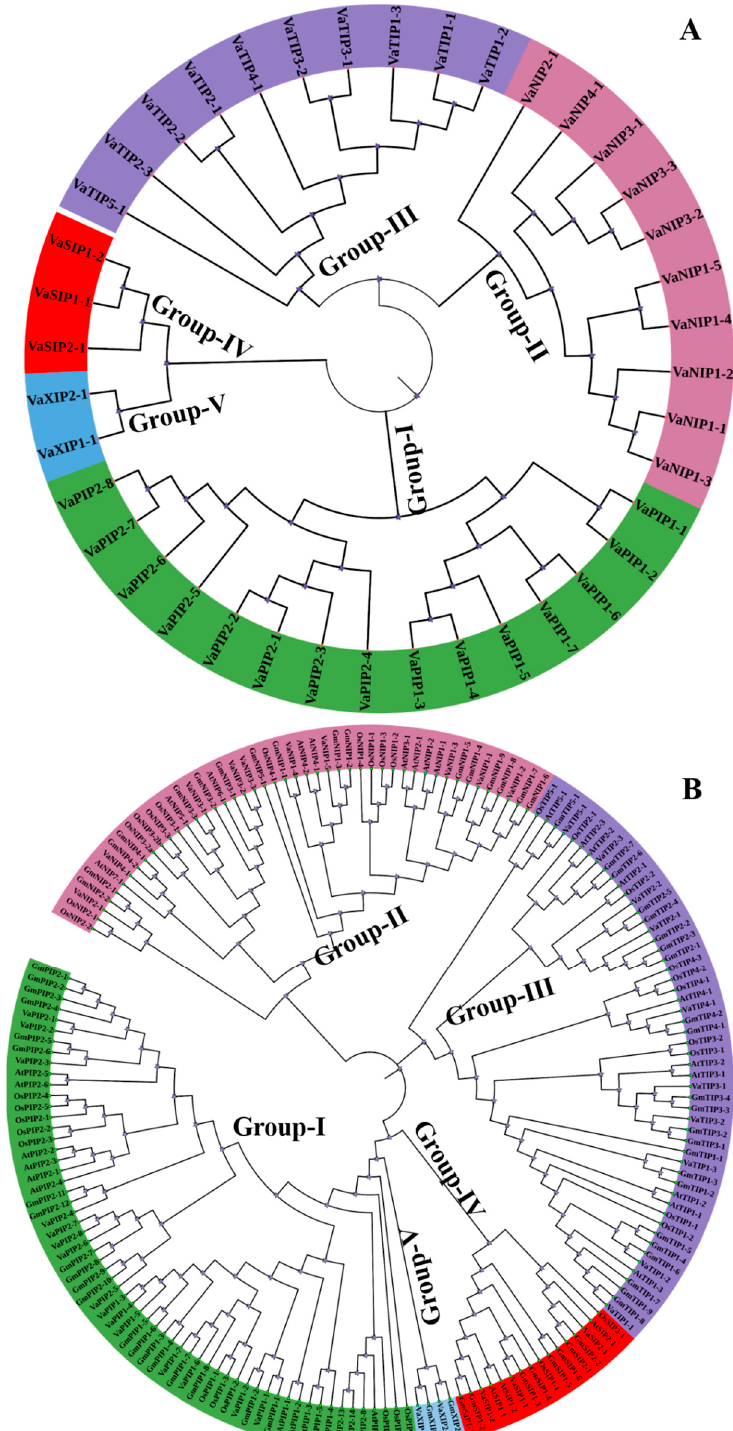
Figure 2. ( A ) Phylogenetic distribution of 40 aquaporins (AQPs) identified in Vigna angularis ( VaAQPs ); and ( B ) phylogenetic analysis of 40 VaAQPs along with the previously identified AQPs from Glycine max , Oryza sativa and Arabidopsis . Prefixes indicate different species, such as At— A. thaliana , Gm— G. max , Os— O. sativa and Va— V. angularis followed by subfamily name and specific number, which are used for the nomenclature of AQPs.